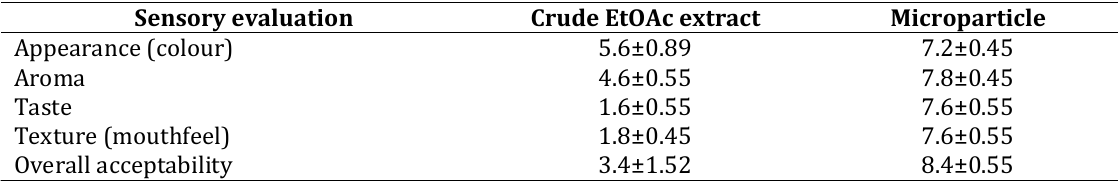
Table III. Sensory perception of crude EtOAc extract and the microparticles Sensory